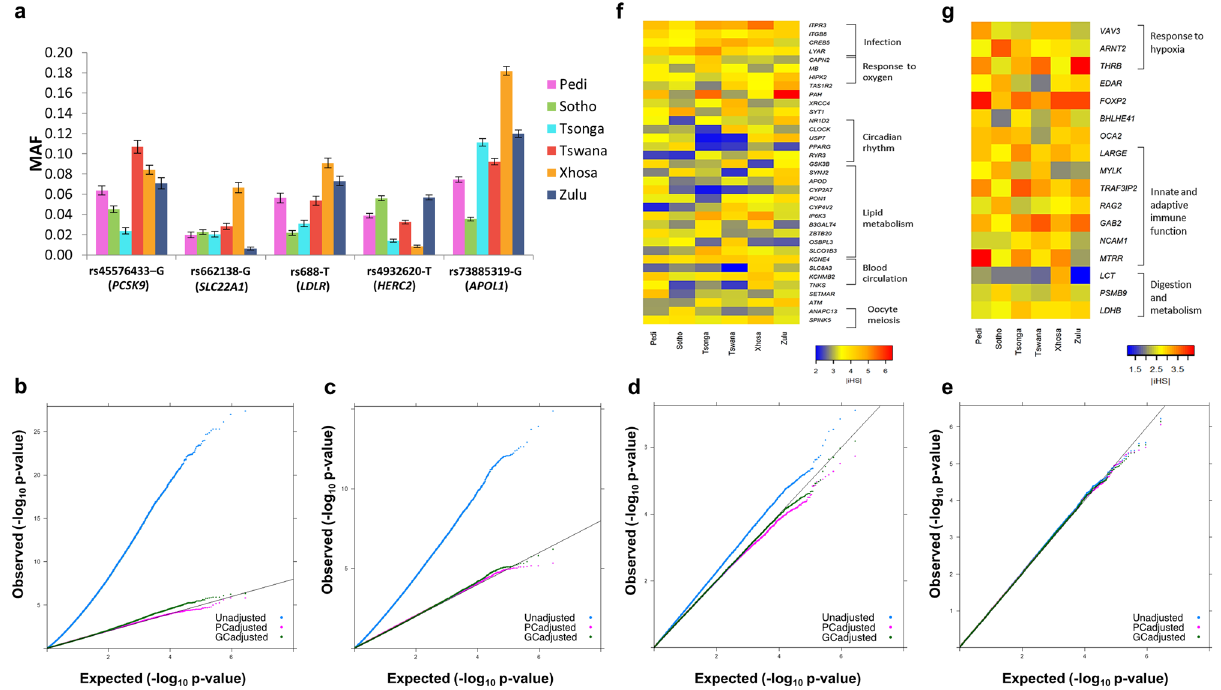
Fig. 4 Possible impact of population structure within the South-Eastern Bantu-speaking (SEB) groups on genome-wide association studies (GWASs) and evolutionary estimates. a Allele frequency variation of some of the well-known phenotype associated SNPs. The mean and the standard error was estimated using 50 random resampling runs with 30 samples each (source data provided in Source Data fi le). b – e Representative QQ plots showing results from simulated-trait GWASs comparing randomly sampled participants from b Agincourt (AGT) as cases to Soweto (SWT) as controls c 62.5% AGT + 37.5% SWT participants as cases to 100% SWT participants as controls. d Random samples from SWT without Tswana as cases to random samples from SWT with Tswana as controls. e Randomly sampled individuals from SWT as cases and controls. The Observed ( − log 10 P -values) represent GWAS association results derived by logistic regression (two-tailed). The Expected ( − log 10 P -values) are those based under the null hypothesis. For b – e , blue dots represent raw P -values, whereas purple and green dots represent P -values after principal component and genomic control based correction, respectively. f Heatmap showing differences in iHS statistics for some of the SNPs that were detected as outliers (|iHS| > 4; P -value < 0.003) in at least two of the SEB groups. g Heatmap showing differences in iHS statistics for SNPs in genes previously reported to be under positive selection, that were also detected to show moderate scores in one or more of the SEB groups (|iHS| > 3, P -value <